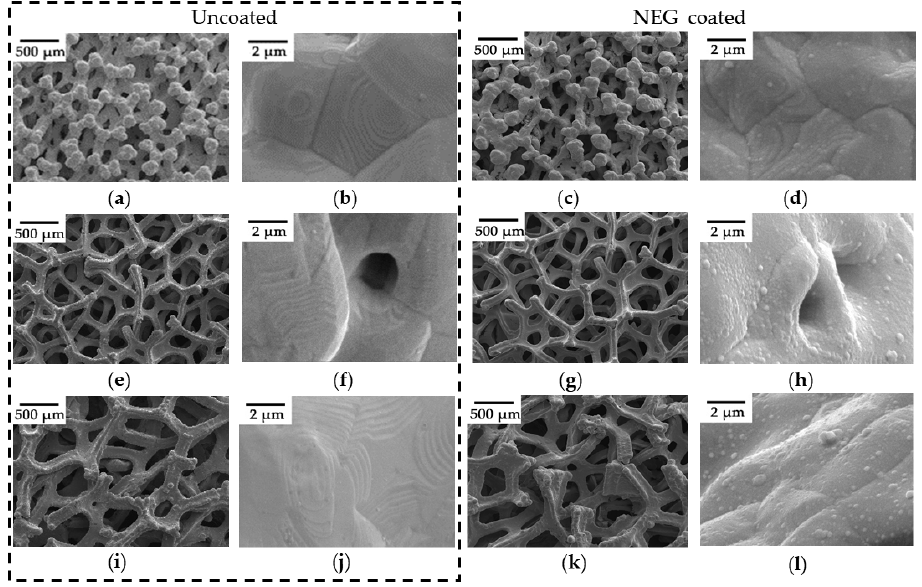
Figure 2. The SEM micrographs of the uncoated/NEG coated porous copper with average pore sizes of 100, 300, and 500 μ m, respectively. ( a , b ) Uncoated, 100 μ m; ( c , d ) 0.65- μ m-thick NEG coated, 100 μ m. ( e , f ) Uncoated, 300 μ m; ( g , h ) 0.65- μ m-thick NEG coated, 300 μ m. ( i , j ) Uncoated, 500 μ m; ( k , l ) 0.65- μ m-thick NEG coated, 500 μ m.